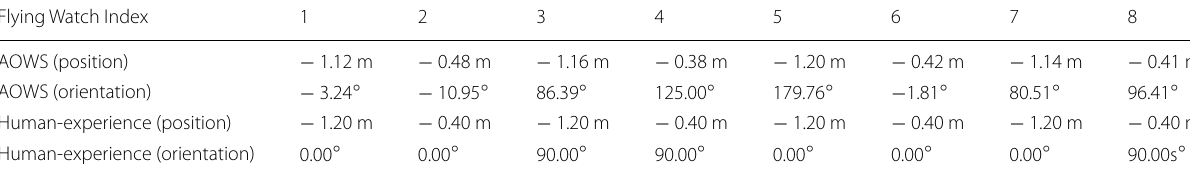
Table 4 Aows-based and human-experience-based allocations of manipulation mission Flying Watch